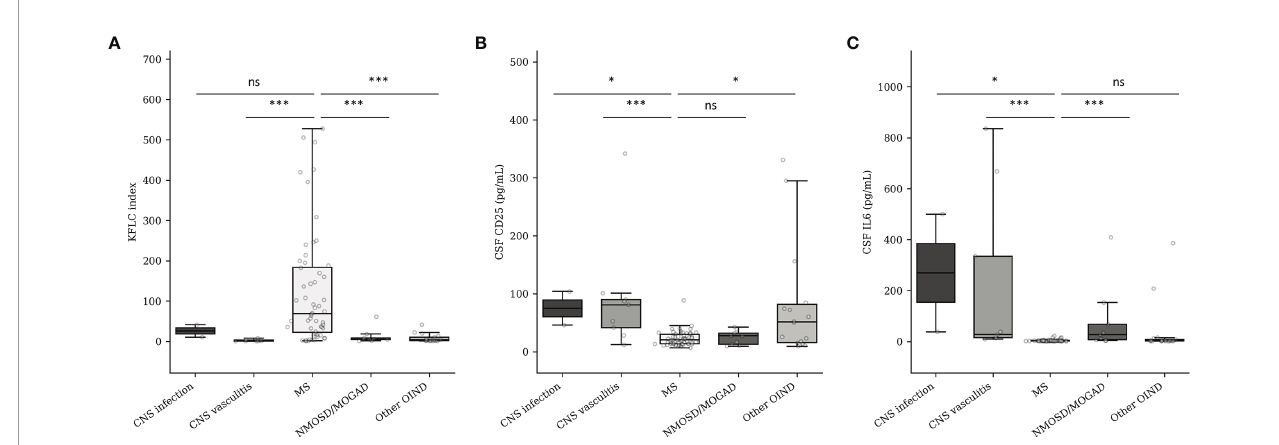
FIGURE 3 | KFLC index (A) , CSF CD25 (B) , and CSF IL-6 (C) expression in MS and OIND subgroups. CNS, central nervous system; MS, multiple sclerosis; MOGAD, myelin oligodendrocyte antibody-associated disorder; NMOSD, neuromyelitis optica spectrum disorder; OIND, other in fl ammatory neurological disorder. Number of patients according to the different subgroups: CNS infection ( n = 2), CNS vasculitis ( n = 9), MS ( n = 58), NMOSD/MOGAD ( n = 9), OIND ( n = 15). ns, non-signi fi cant ( p > 0.05). * p < 0.05. *** p < 0.001.